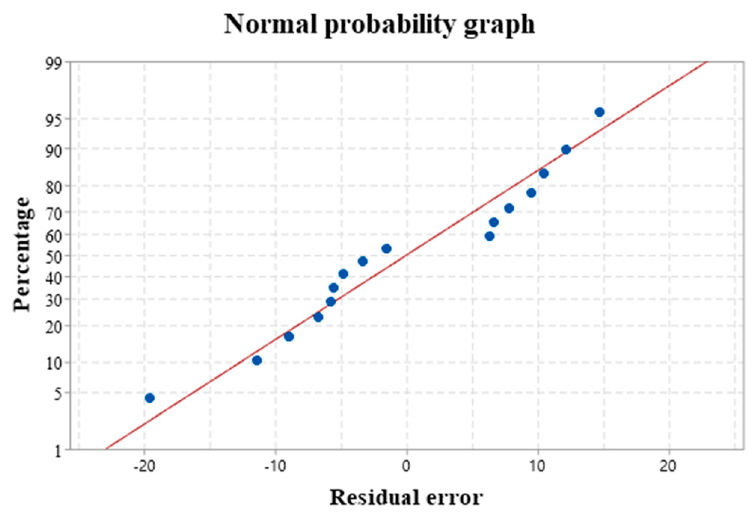
Figure 15. Normal distribution of wear volume.